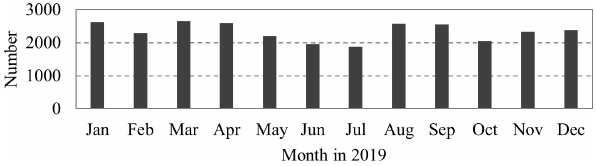
Figure 1. Number of S1 EW images collected in the Arctic region (72.5–83 ◦ N) in each month in